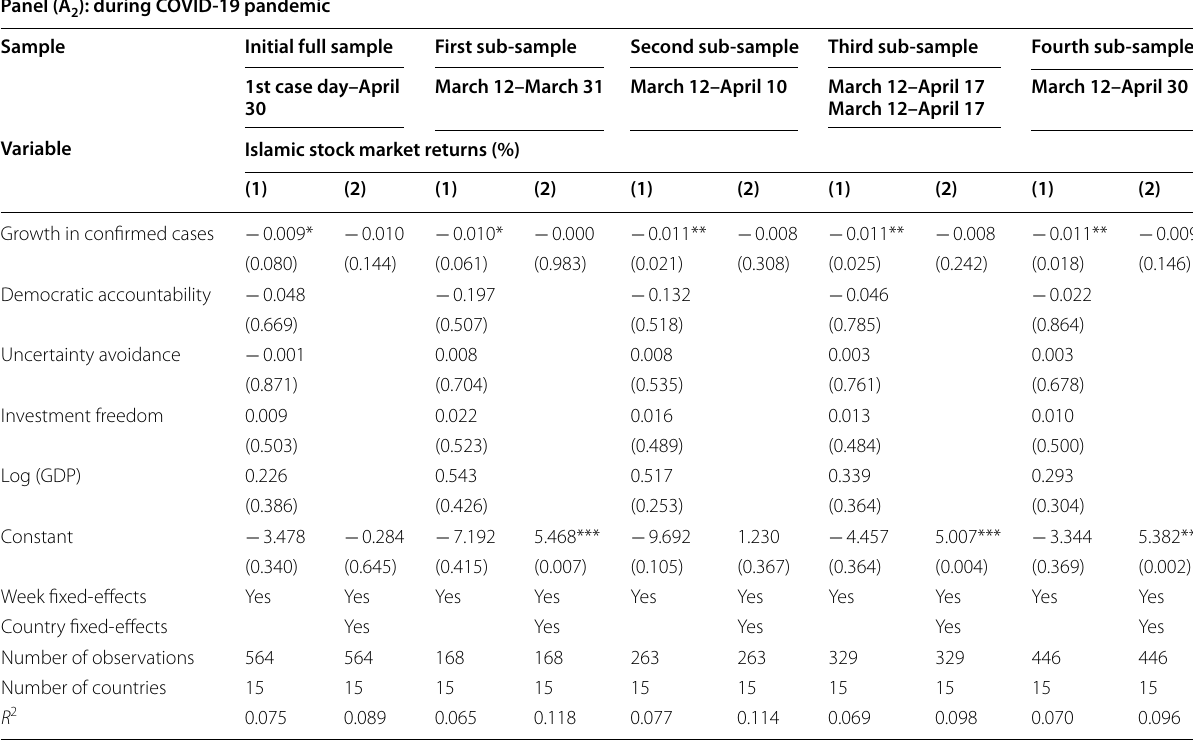
Table 4 Regression results for the impact of COVID-19 on Islamic stock market returns